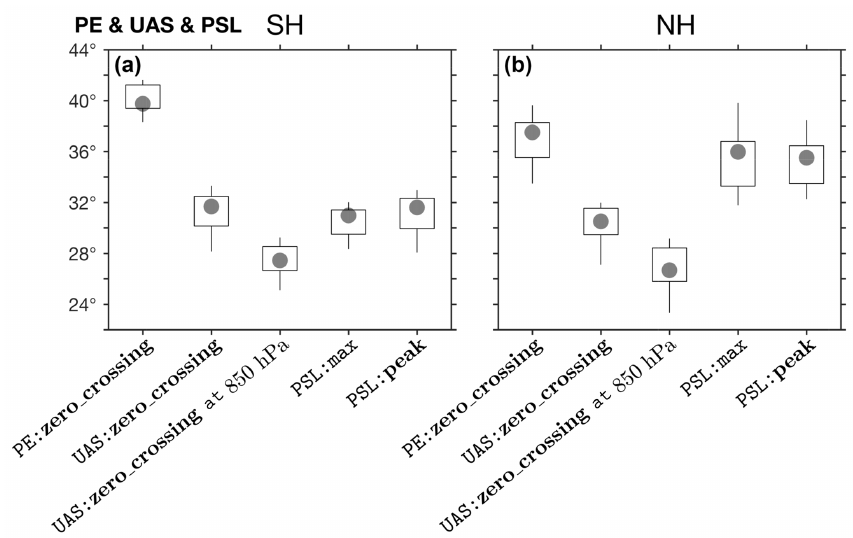
Figure 16. As in Fig. 12a, b for PE:zero_crossing , UAS:zero_crossing using the zonal wind both at the surface and at the 850hPa level, PSL:max , and PSL:peak